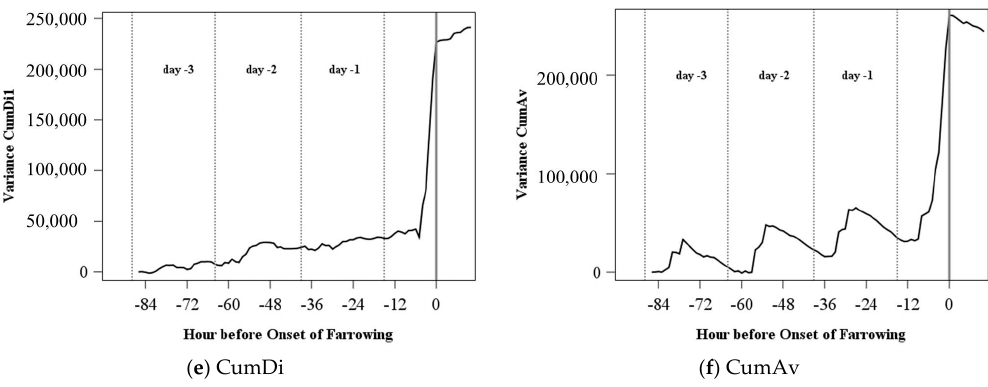
Figure 3. Exemplary acceleration indices of one sow based on the distribution characteristic variance for a time period of 60 min and a range of the moving average of 1 for one sow.